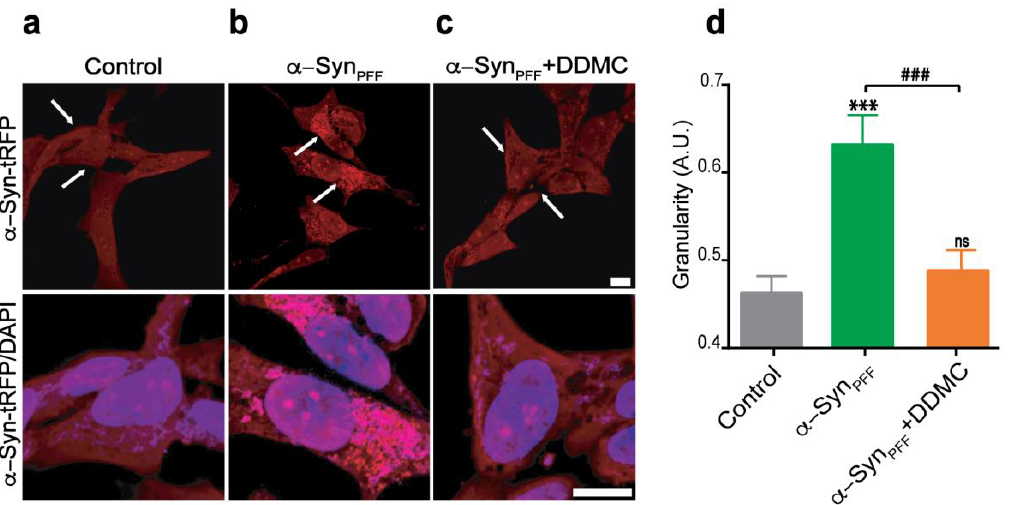
Figure 4. Effect of DDMC on α -Syn PFF -induced seeding of cytoplasmic α -Syn. ( a – c ) SH-SY5Y transgenic cell line (Innoprot #P30707-02) expressing α -Syn-tRFP treated with α -Syn PFF or α -Syn PFF +DDMC (10 µ M). The lower panel corresponds to an enlargement of the region indicated with the white arrows together with DAPI counterstaining. ( d ) Granularity was quantified using CellProfiler 4.2.1. Statistical significance is indicated as: *** p < 0.001 vs. Control; ### p < 0.01 vs. α -Syn PFF ; ns not significant vs. Control.